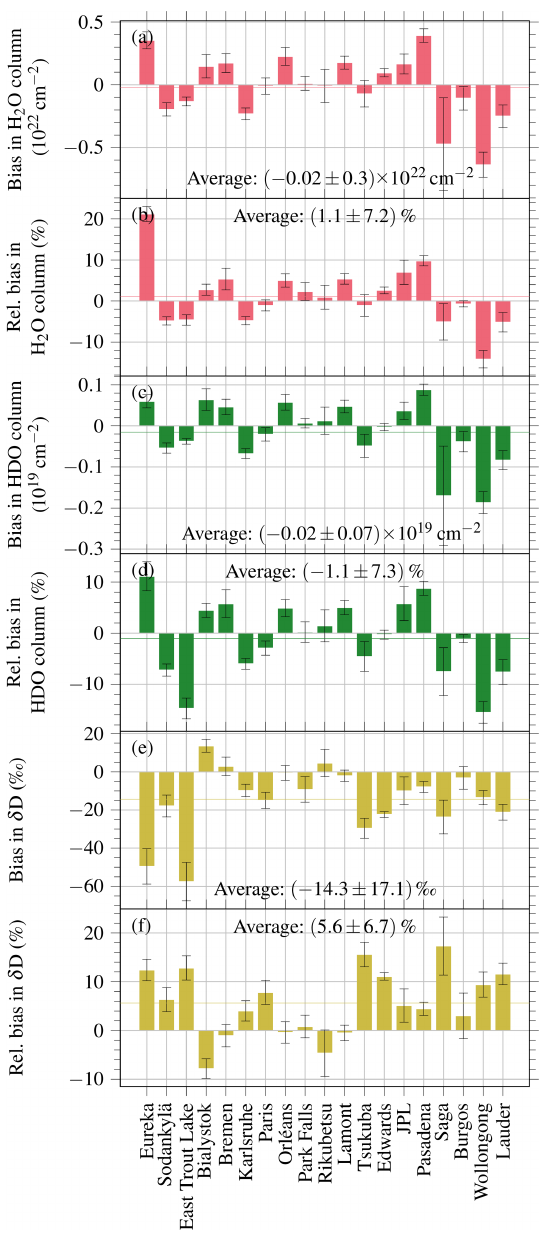
Figure 8. Biases for all TCCON stations. (a) Bias in H 2 O and its standard error. (b) Relative bias in H 2 O and its standard error. (c) Bias in HDO and its standard error. (d) Relative bias in HDO and its standard error. (e) Bias in a posteriori δ D and its standard error. (f) Relative bias in a posteriori δ D and its standard error. The horizontal line in all panels visualises the average over all stations.